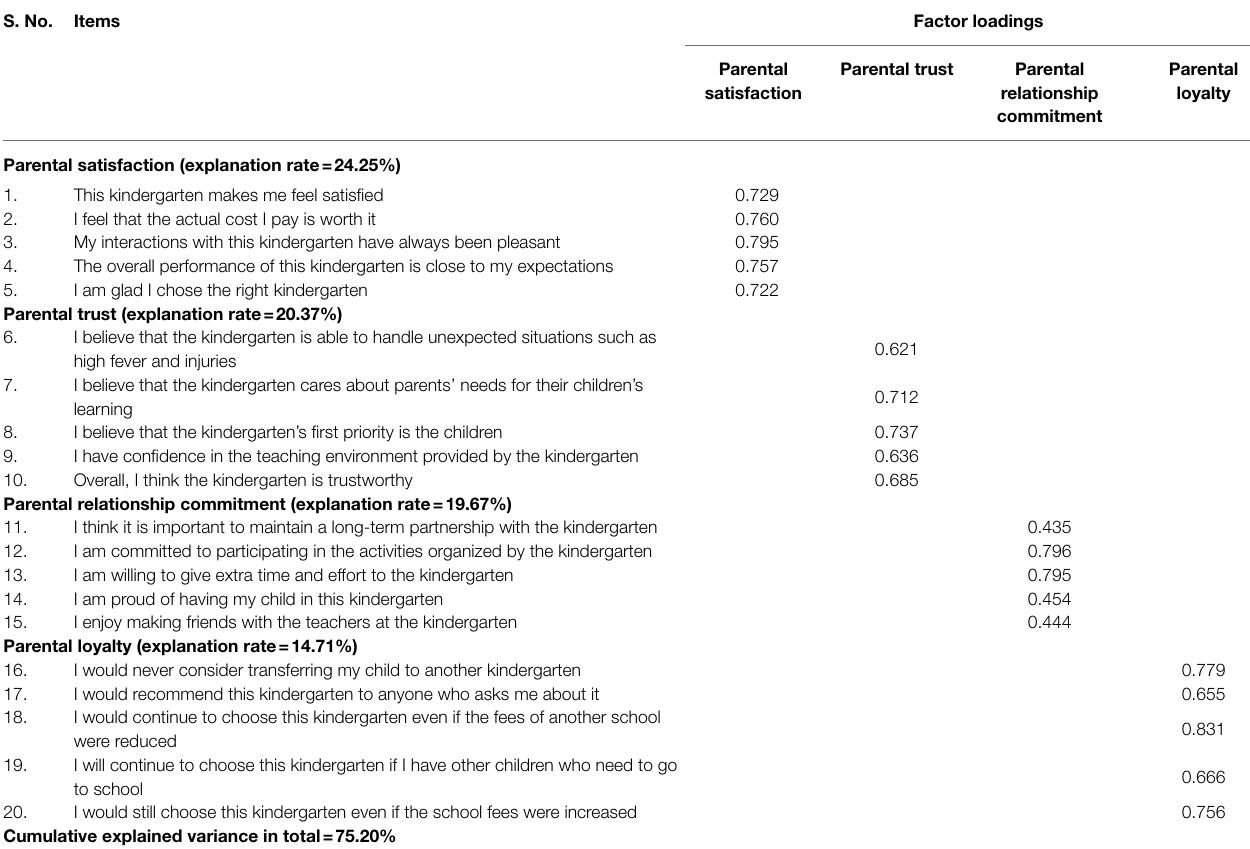
TABLE 1 | Summary table of exploratory factor analysis.